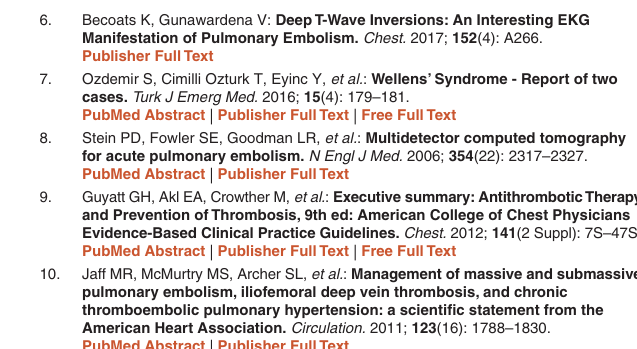
Supplementary File 1. Video file of angiogram showing patent coronaries Click here to access the